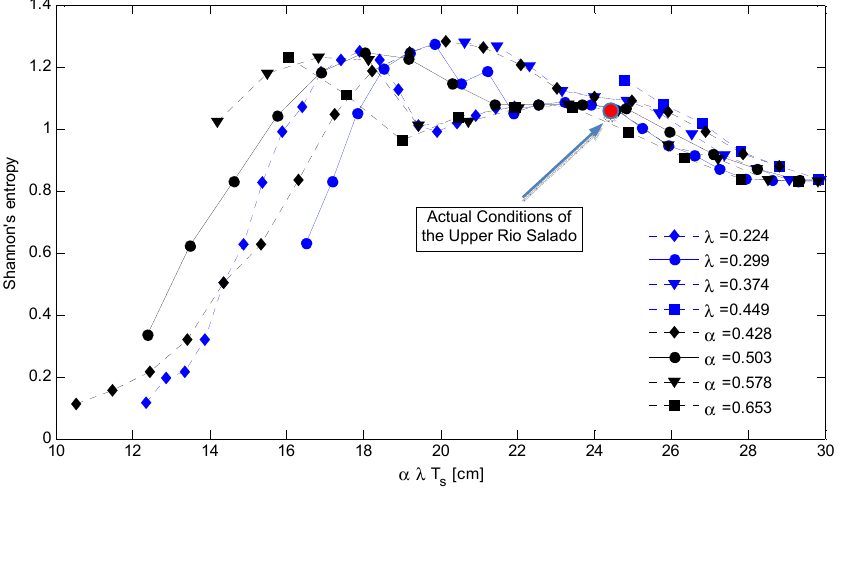
Figure 6. Distribution of the Shannon’s Index computed on the simulated vegetation patterns as a function of the mean rainfall depth during the growing season ( α λ T assigned values of the rainfall parameters α and λ . The full red circle describes the relative position of the Rio Salado basin under the actual climatic